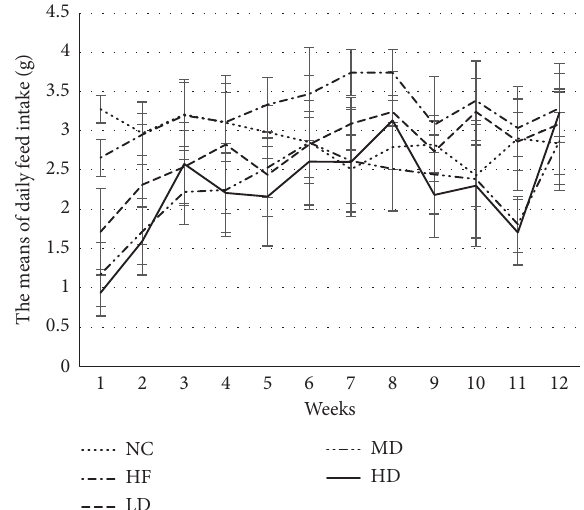
Figure 1: The daily feed intake of each week (means ± SD, g). ∗ Compared with the LD group, the difference was statistically significant ( P < 0 . 05).